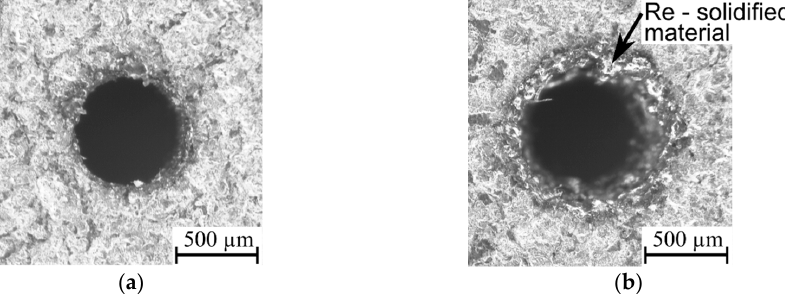
Figure 14. The entrance diameter of a micro-hole fabricated by the pulse time duration: ( a ) t on = 325 µs and I = 2.66 A, U = 100 V, p = 6 MPa, n = 400 rpm; ( b ) t on = 775 µs and I = 2.66 A, U = 100 V, p = 6 MPa, n = 400 rpm.